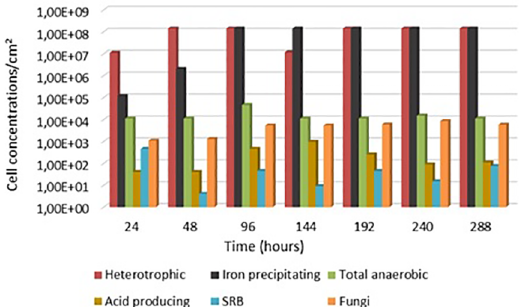
Figure 3. Cell concentrations of heterotrophic aerobic bacteria, iron-precipitating bacteria, total anaerobic bacteria, acid producing bacteria, SRB and fungi in clayey soil with the time